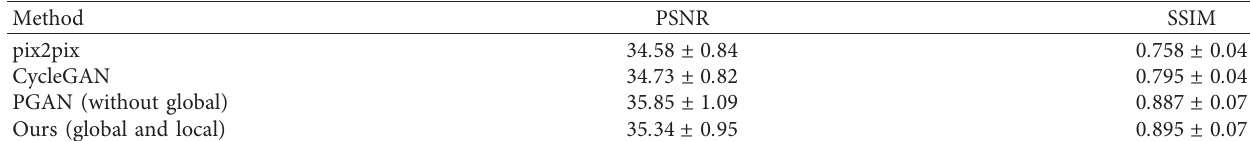
Table 2: Comparisons of T1-weight MRI synthesis between our proposed method with different approaches of PSNR and SSIM (data in the table denote the average value and standard deviation of the test dataset).